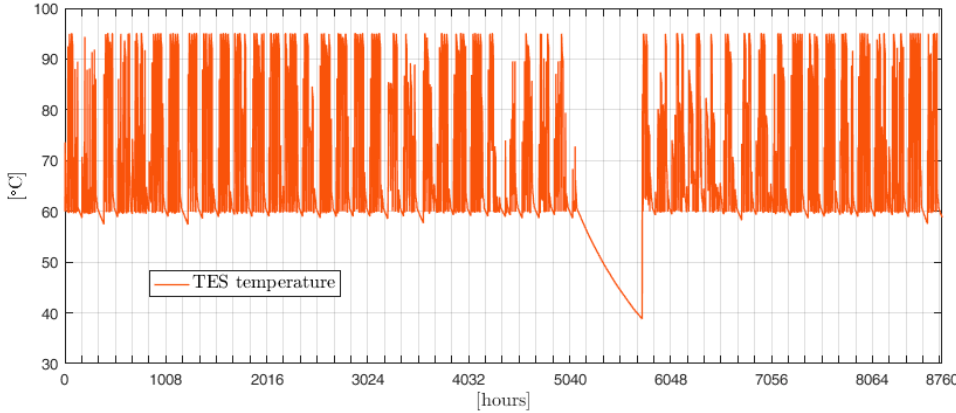
Figure 11. Hourly equivalent TES temperature during the year.